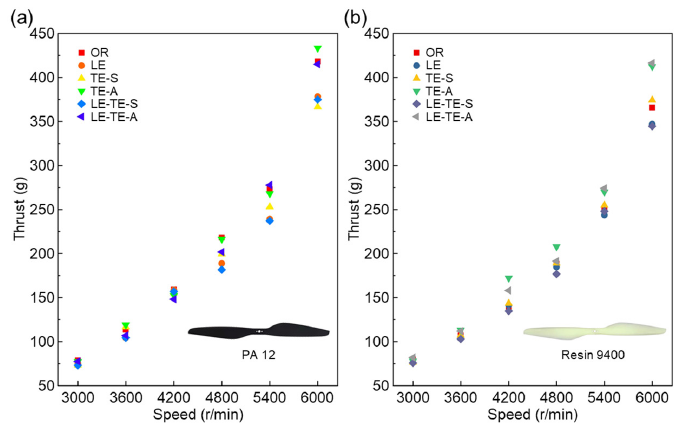
Figure 8. Thrust performance with different rotors. ( a ) Thrust performance of bionic rotors with PA 12; ( b ) Thrust performance of bionic rotors with Resin 9400.